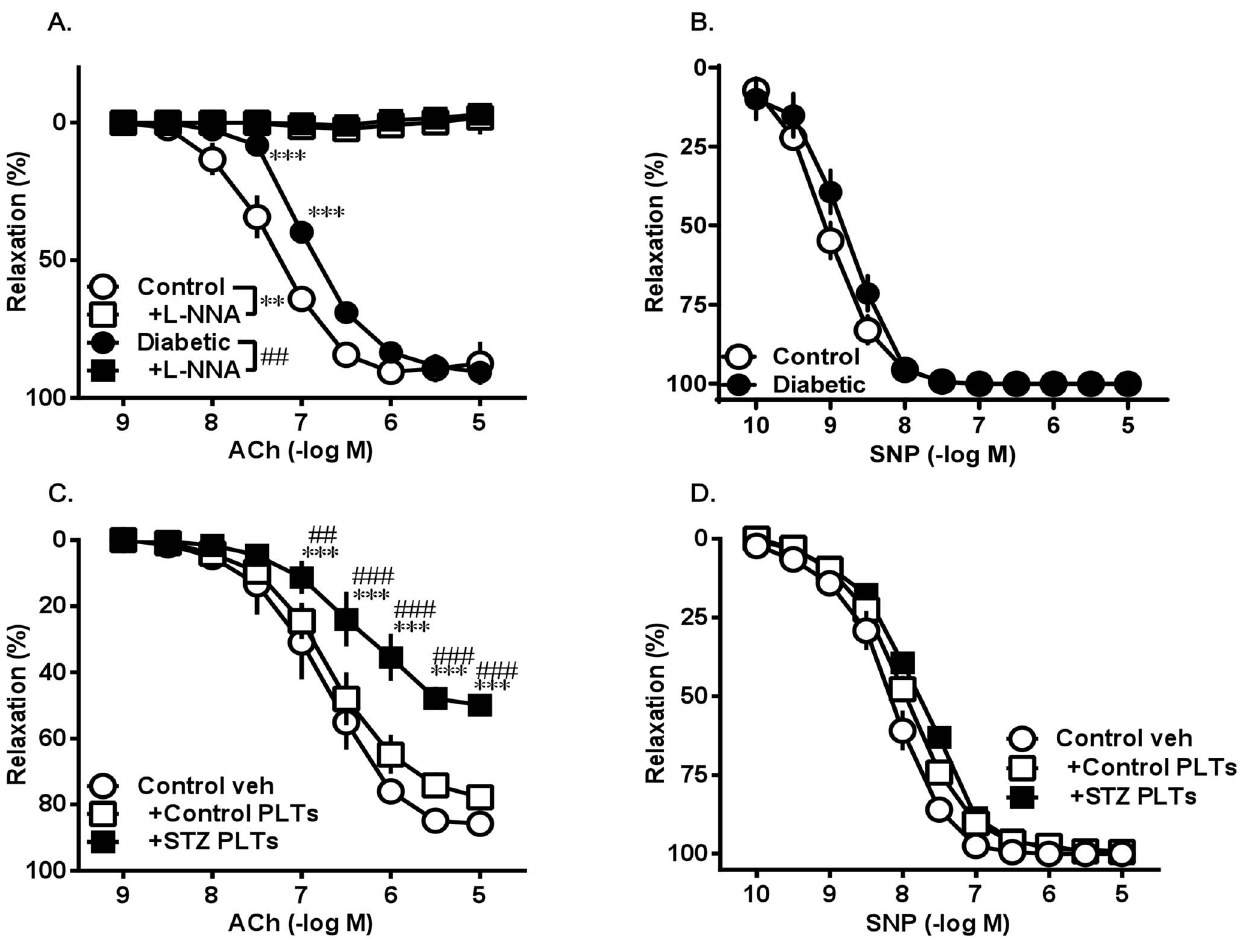
Figure 2. Concentration-response curves for endothelium-dependent vasorelaxation elicited by the cumulative application of ACh (A and C) and endothelium-independent relaxation by incremental concentrations of SNP (B and D) in isolated carotid arterial rings. (A) Effects of the NOS inhibitor L-NNA on the ACh-induced relaxation of carotid arterial rings from control and diabetic (STZ-induced) rats. Carotid arterial rings were preincubated with L-NNA (10 2 4 M; 30 min). (C and D) Effects of PLTs. ACh-induced (C) and SNP-induced (D) vasorelaxation of carotid arterial rings from controls induced for 30 min with PLTs isolated from control (Control PLTs) and diabetic (STZ PLTs) rats. Carotid arterial rings were preincubated with each type of PLT (1.65 6 10 7 cells/mL; 30 min). Data are means 6 SE; n=5; ***P , 0.001 vs. Control, ## P , 0.01 or ### P , 0.001 vs. Diabetic or + Control PLTs.